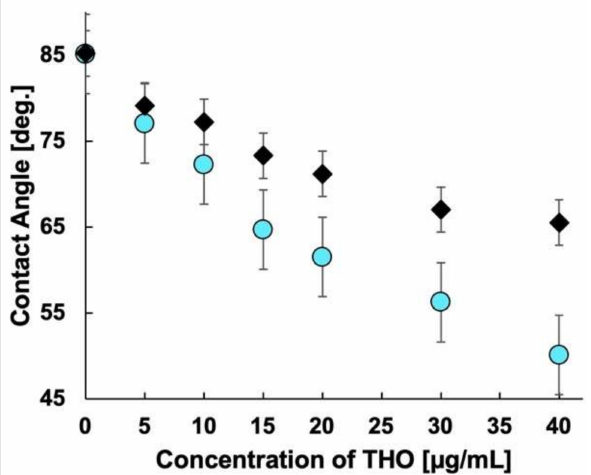
Figure 8. Receding angle measurement for MIP and NIP with change in theophylline concentration. Circle and rhombus show the receding angles for MIP and NIP,